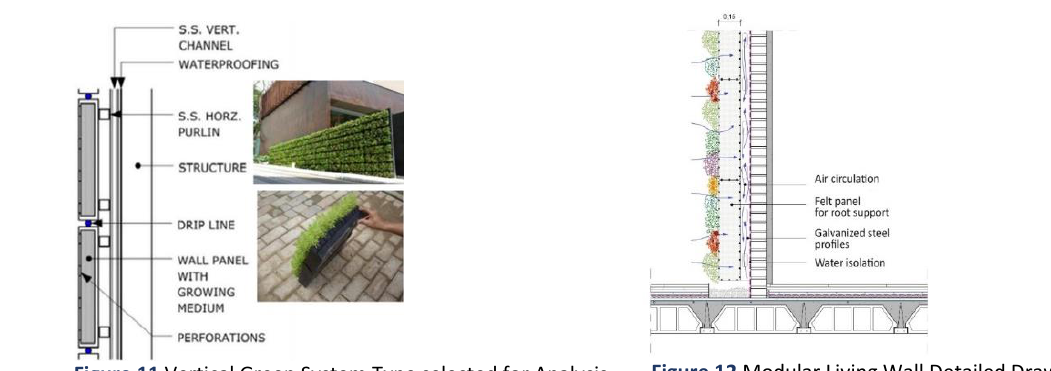
Figure 11 Vertical Green System Type selected for Analysis (Papadopoulou G.,2013)